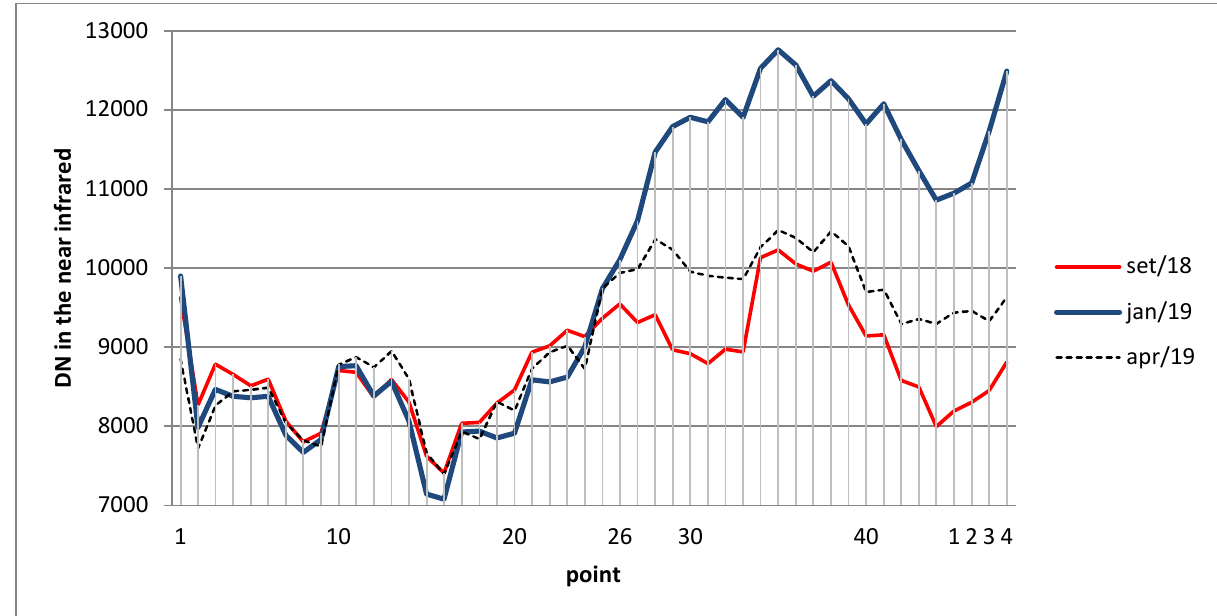
Figure 6 –Digital values in the near infrared image of Landsat/OLI along the Paraopeba